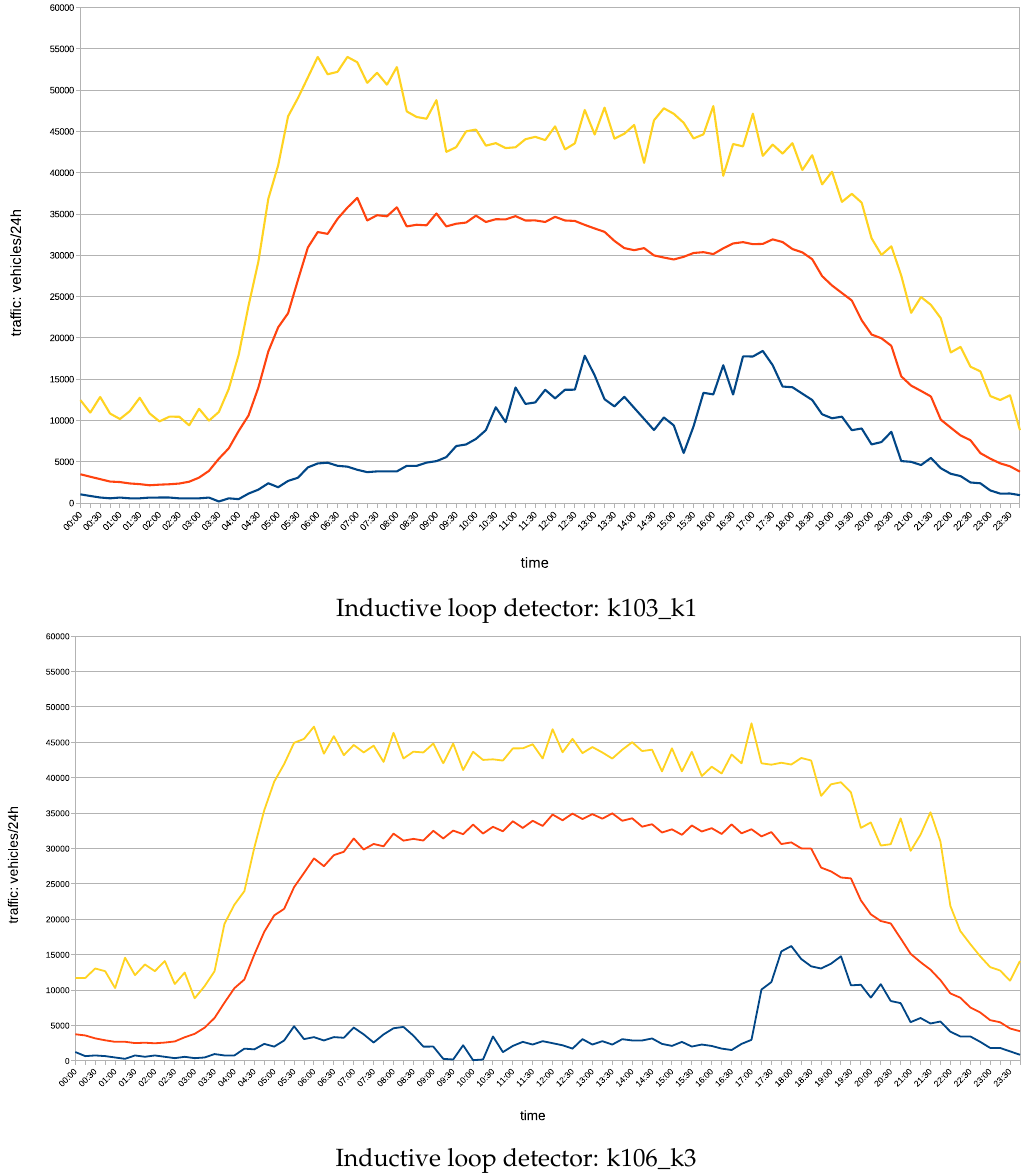
Figure 1. Daily traffic intensity, one year of data; maximum, minimum and average